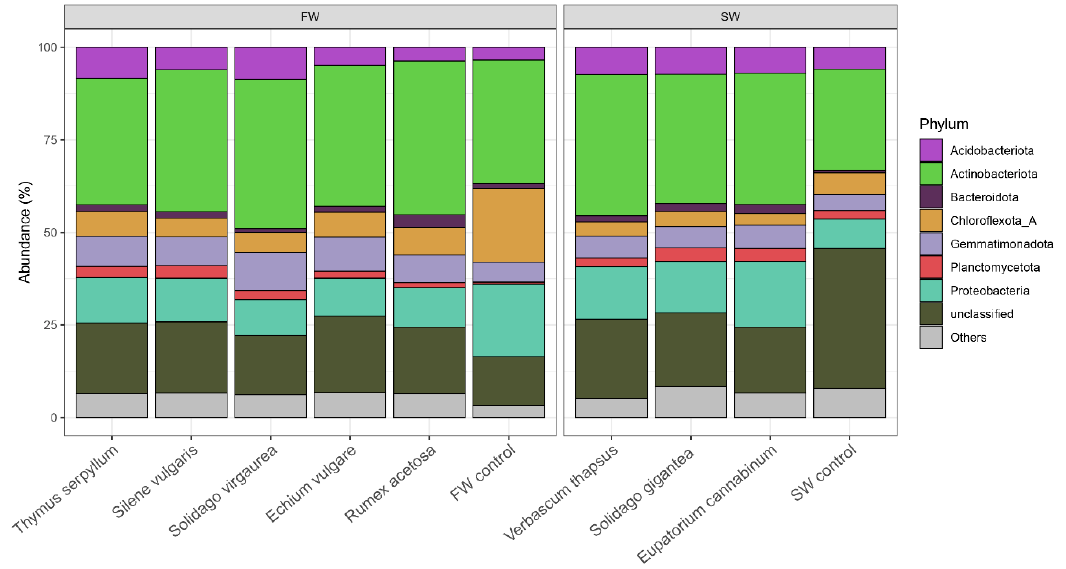
Figure 4. Most abundant phyla in the root zone of the spontaneous plant species.